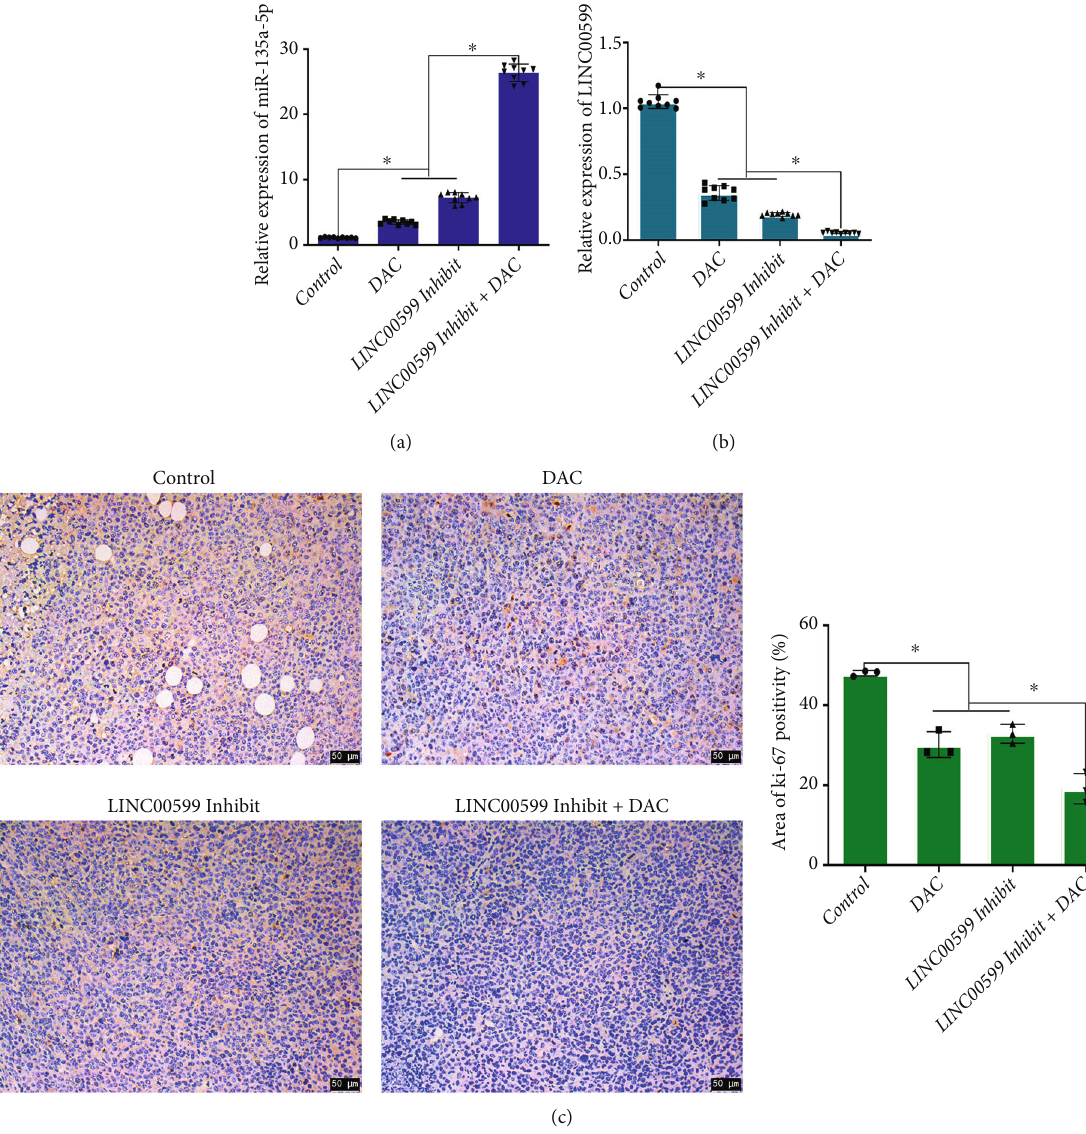
Figure 7: DAC in fl uencing the expression of LINC00599, miR-135a-5p, and ki-67 in tumor tissues through LINC00599. qPCR analysis detecting the expression level of (a) miR-135a-5p and (b) LINC00599 in tumor tissues of each group. (c) Immunohistochemical analysis detecting ki-67 expression in tumor